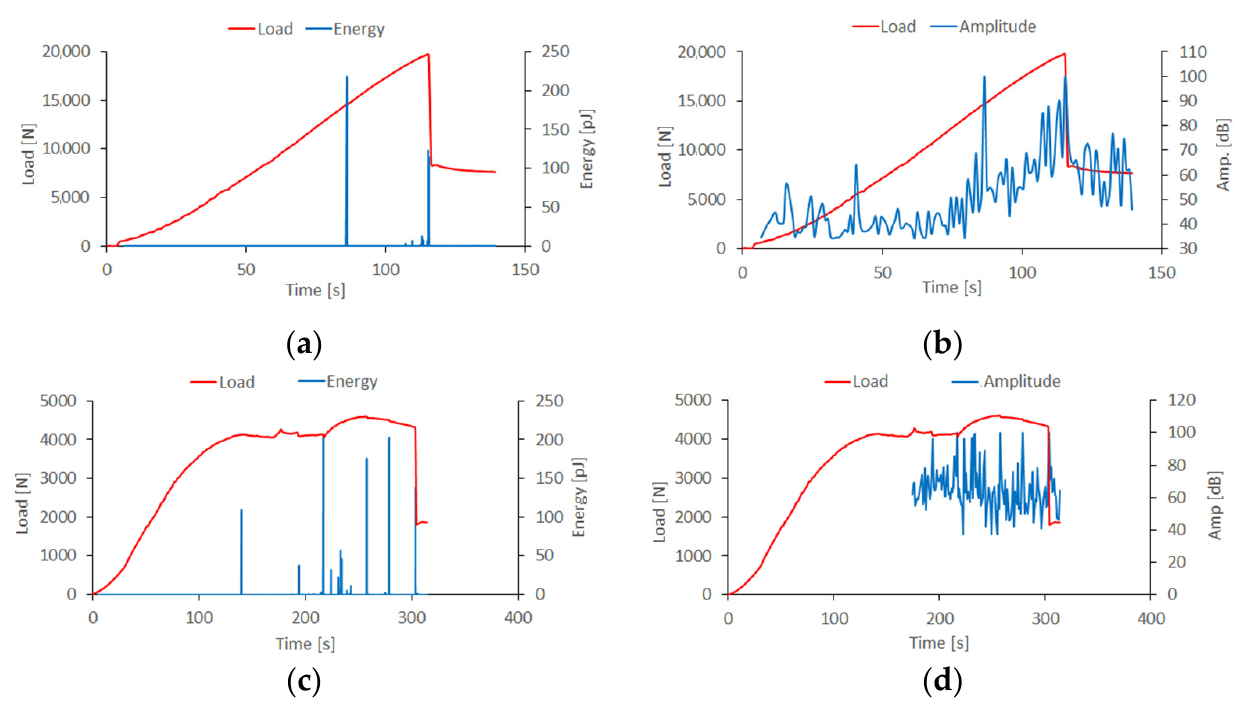
Figure 5. Post-buckling equilibrium paths with selected acoustic emission signals: ( a ) top-hat column energy signal, ( b ) top-hat column amplitude signal, ( c ) channel column energy signal, ( d ) channel column amplitude signal.